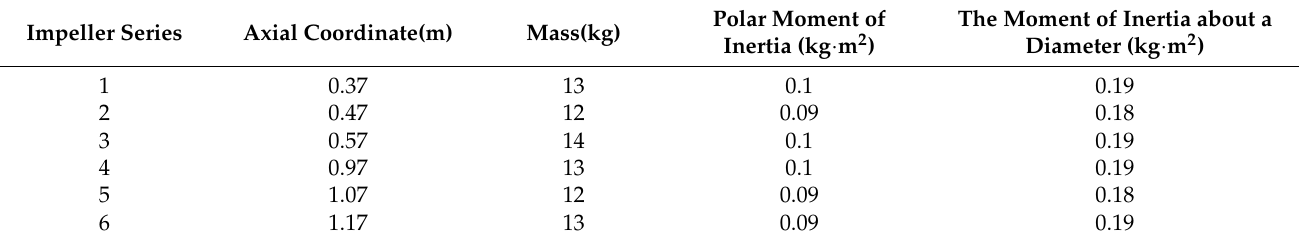
Table 2. The specific parameters of the impellers.